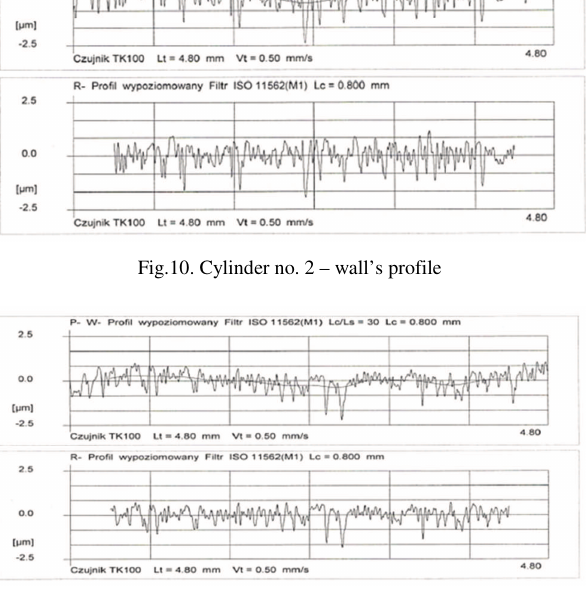
Fig.11. Cylinder no. 3 – wall’s profile Table 4. Results of measurements of cylinder wall